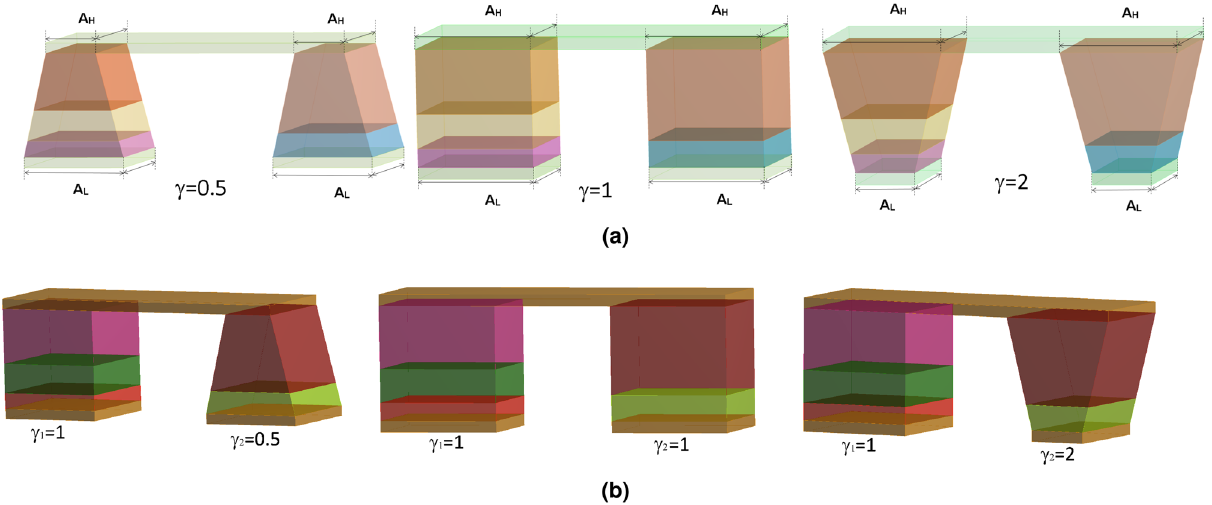
Figure 3. Evolution of the geometry of the elements in the TEG according to the geometric factor ( γ ) for ( a ) symmetric and ( b ) asymmetrical